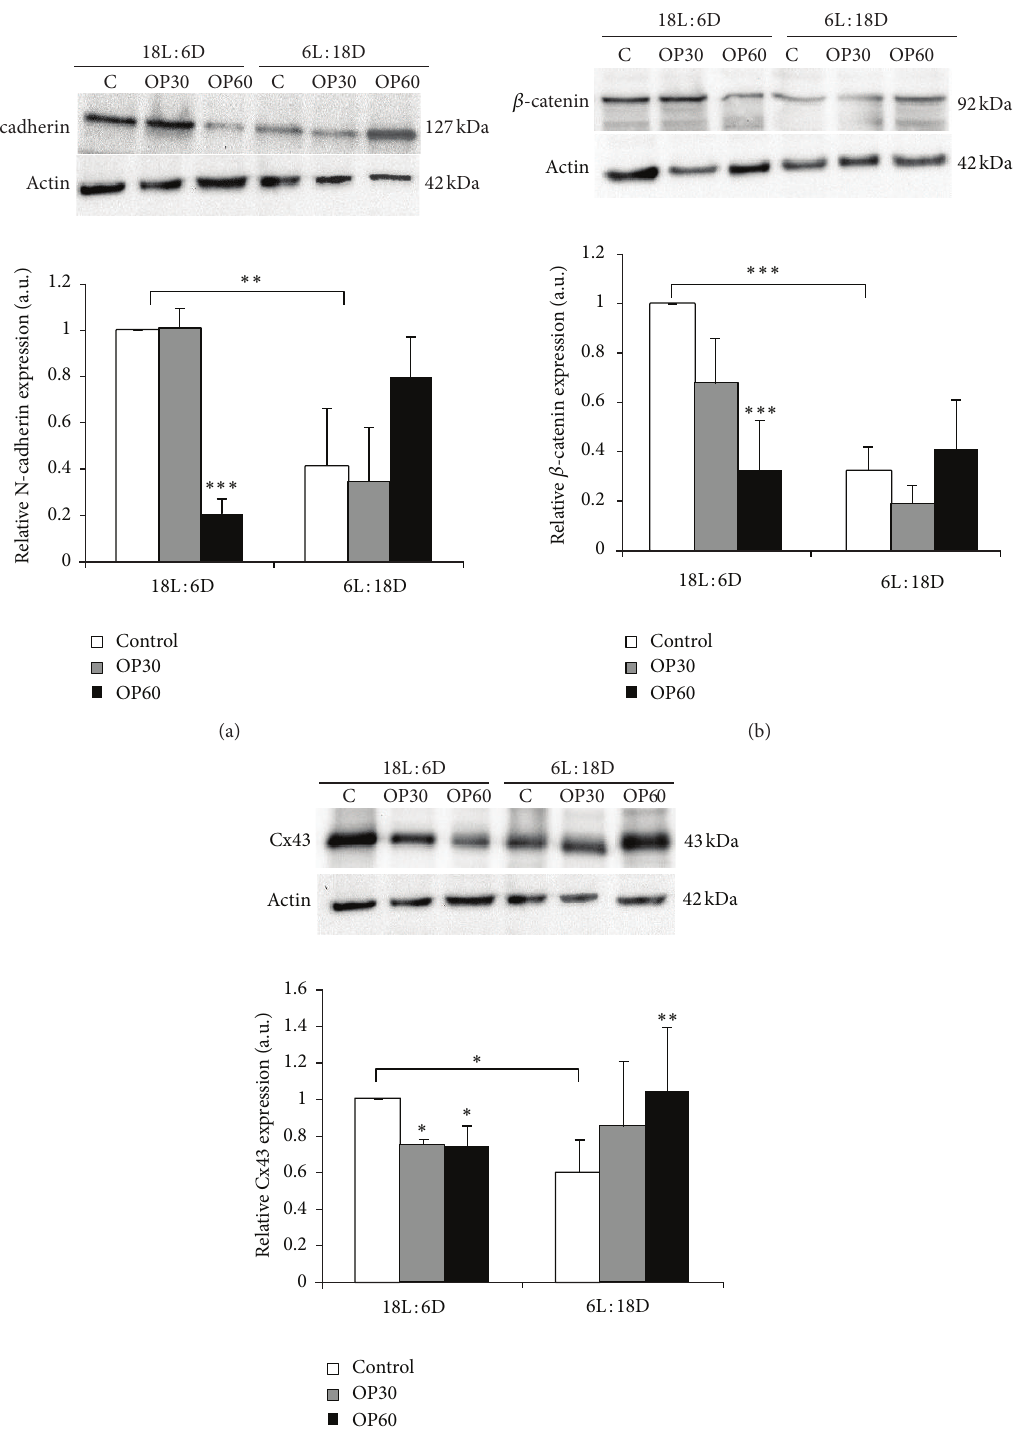
Figure 2: Representative Western blot analyses and relative N-cadherin (a), 𝛽 -catenin (b), and connexin 43 (c) protein expression levels in testicular homogenates of bank voles kept in either long light cycles (18L:6D) or short light cycles (6L:18D) treated with vehicle ( 𝑛 = 6 ) or with 4- tert -octylphenol for 30 and 60 days (OP30, 𝑛 = 6 ; OP60, 𝑛 = 6 ). The relative amount of N-cadherin, 𝛽 -catenin, and connexin 43 proteins normalized to 𝛽 -actin. Data obtained from three separate analyses is expressed as mean ± SD. Significant differences from control values are denoted as ∗ 𝑃 < 0.05 , ∗∗ 𝑃 < 0.01 , and ∗∗∗ 𝑃 < 0.001